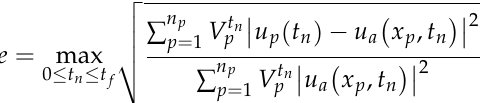
Figure 11. Problem statement of two 2D elastic disks’ impact.